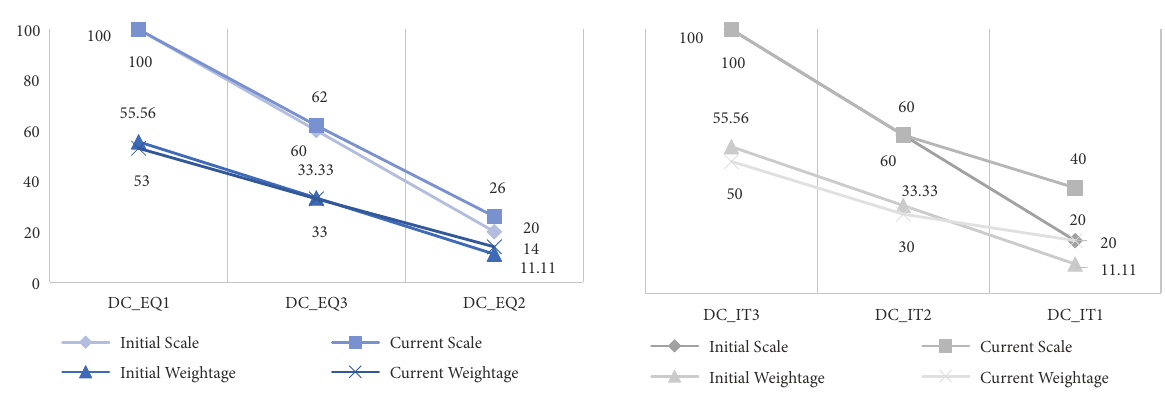
Figure A21. Model modification for sub-criteria of EQ Figure A22. Model modification for sub-criteria of